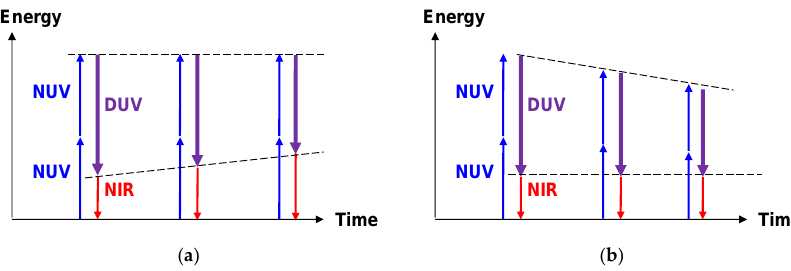
Figure 6. The energy diagram of the four-wave mixing (FWM) induced by ( a ) a positively-chirped NIR pulse; and a non-chirped near-ultraviolet (NUV) pulse and that induced by ( b ) a negatively chirped NUV pulse and a non-chirped NIR pulse. These show that both the negative frequency chirp in the NUV pulse and the positive frequency chirp in the NIR pulse lead to the negative frequency chirp in the DUV pulse.